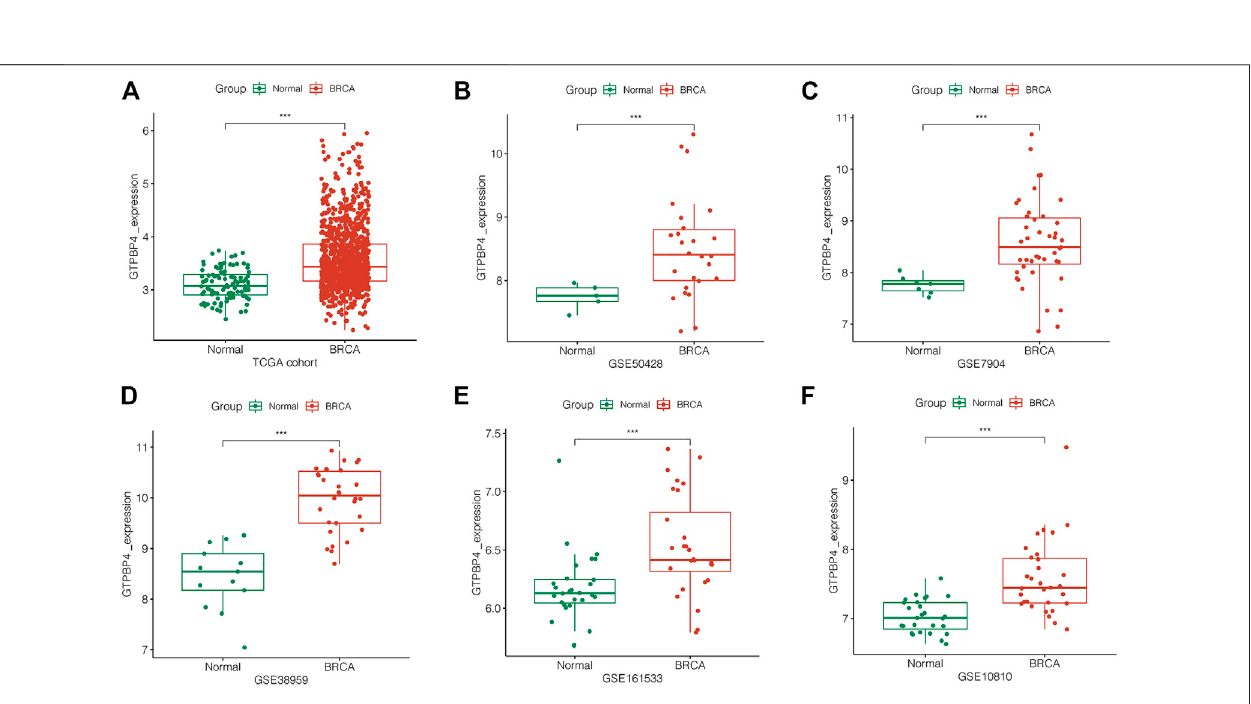
Frontiers in Pharmacology |